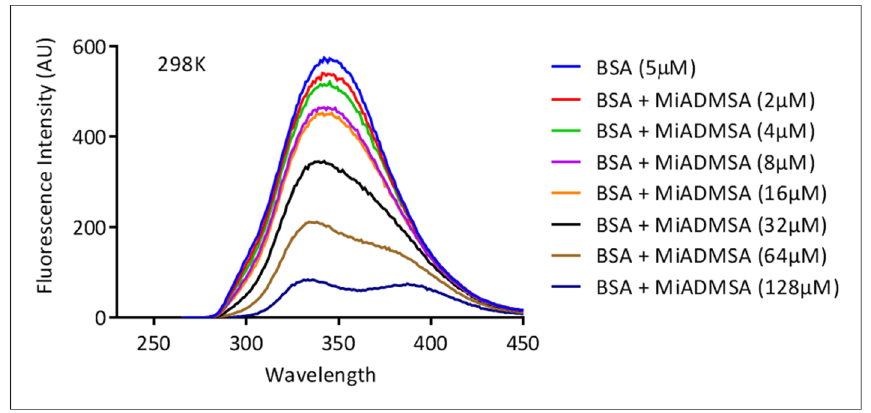
Figure 2. The fluorescence quenching of BSA (5 µM) with increasing concentration of MiADMSA (0–128 µM) at 298 K.